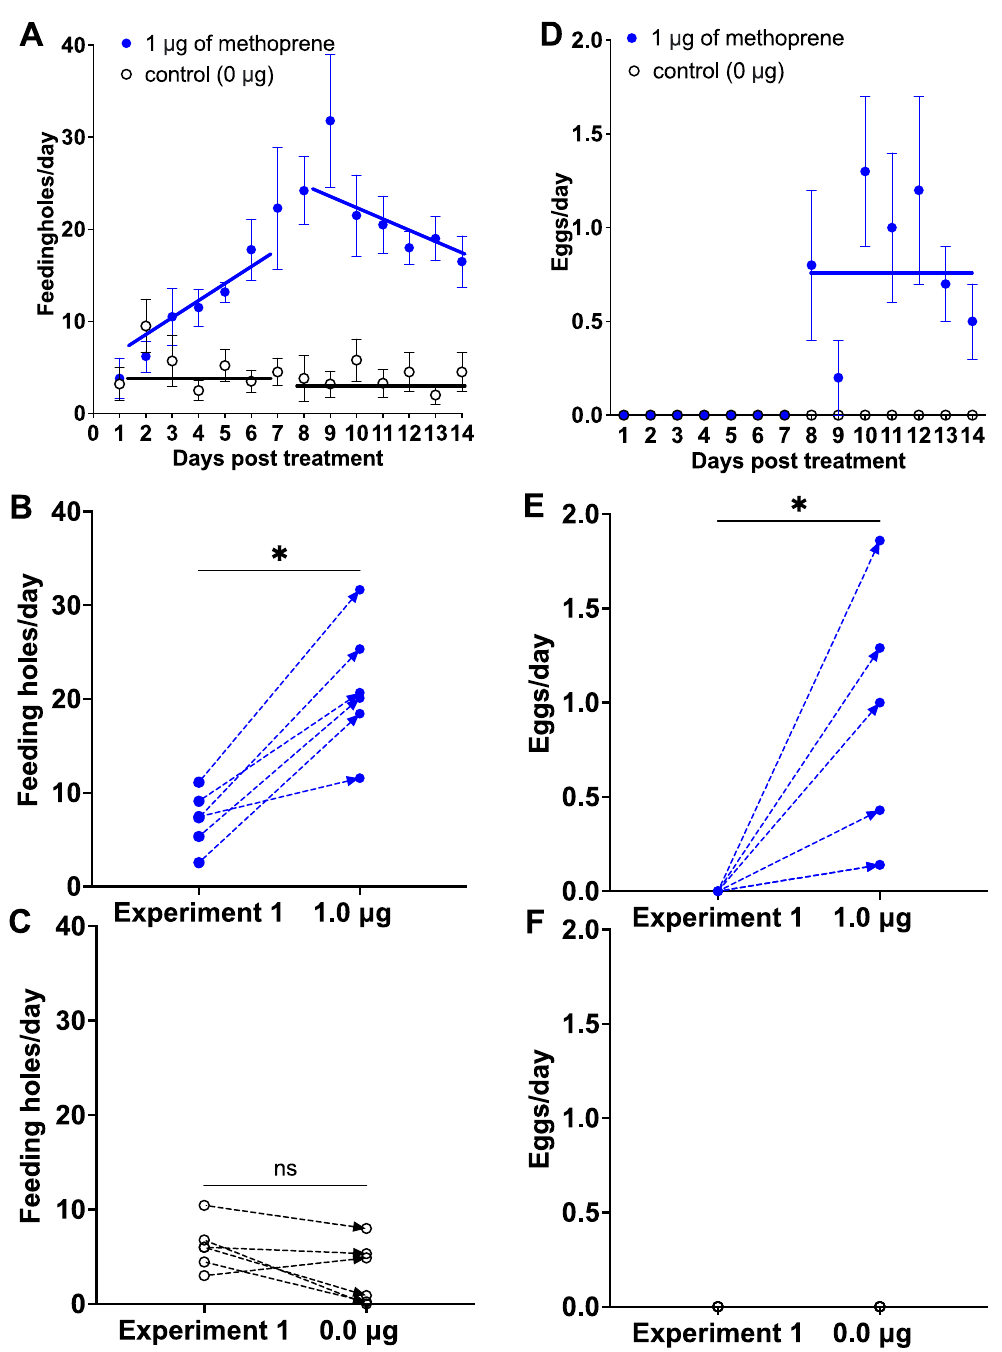
Figure 2. The effect of applying 1 µ g of methoprene (blue dot) vs. control (1 µ g of acetone; white dot) on females used in Experiment 1 that did not oviposit after being treated with 0, 0.1, or 0.01 µ g of methoprene (Figure 1). Mean number ± SE of feeding holes over time (( A ); solid lines represents linear regressions for the preoviposition and oviposition periods) and individual responses of each female treated with methoprene ( B ) and treated with acetone ( C ) in Experiment 1 and Experiment 2; mean number of eggs over time ( D ) and individual responses of each female retreated with methoprene ( E ) and with acetone ( F ) during the oviposition period; ns: not significant, *: p < 0.05, paired Wilcoxon signed-rank test.